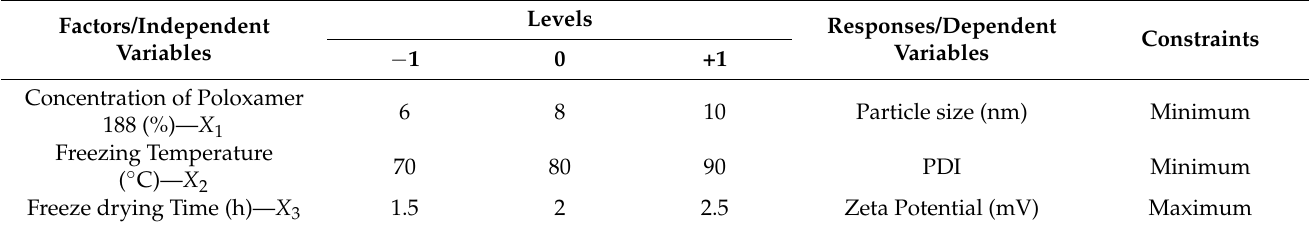
Table 8. Experimental plan for BBD in terms of actual and coded